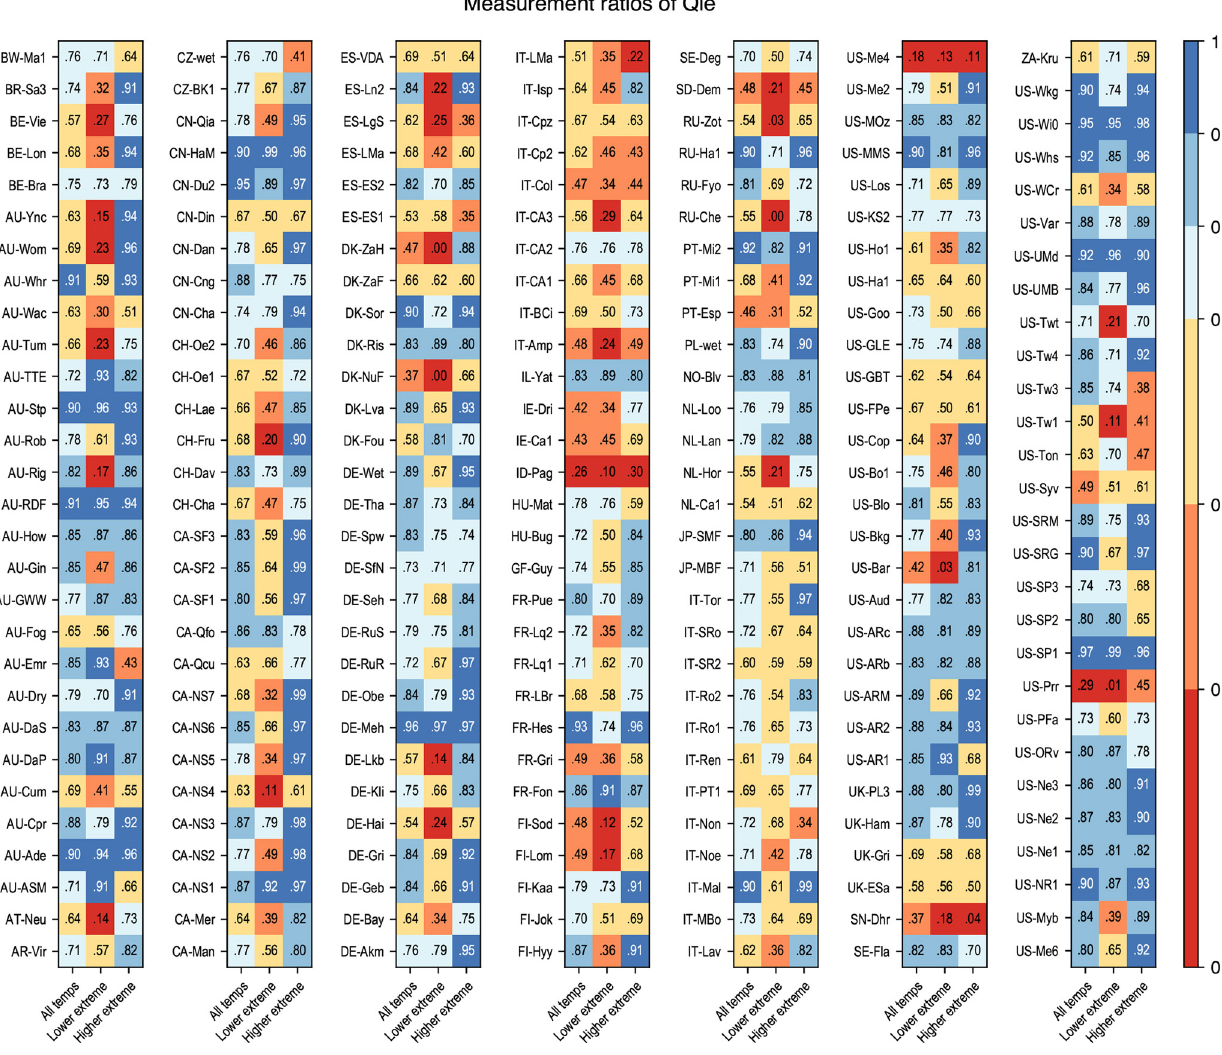
Figure 6. Q le measurement ratios of flux tower sites for all temperatures, the lower extreme temperatures and the upper extreme